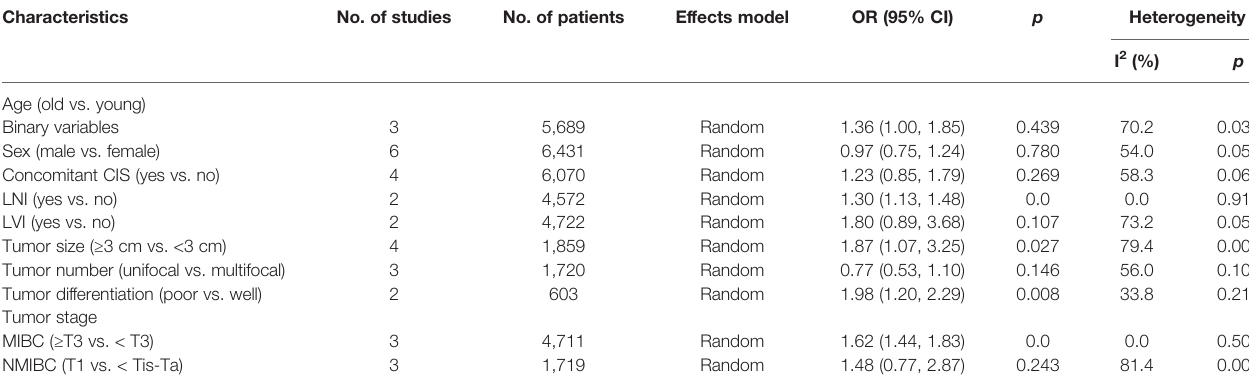
TABLE 3 | Correlations of SII and clinicopathological characteristics in patients with bladder cancer. Characteristics